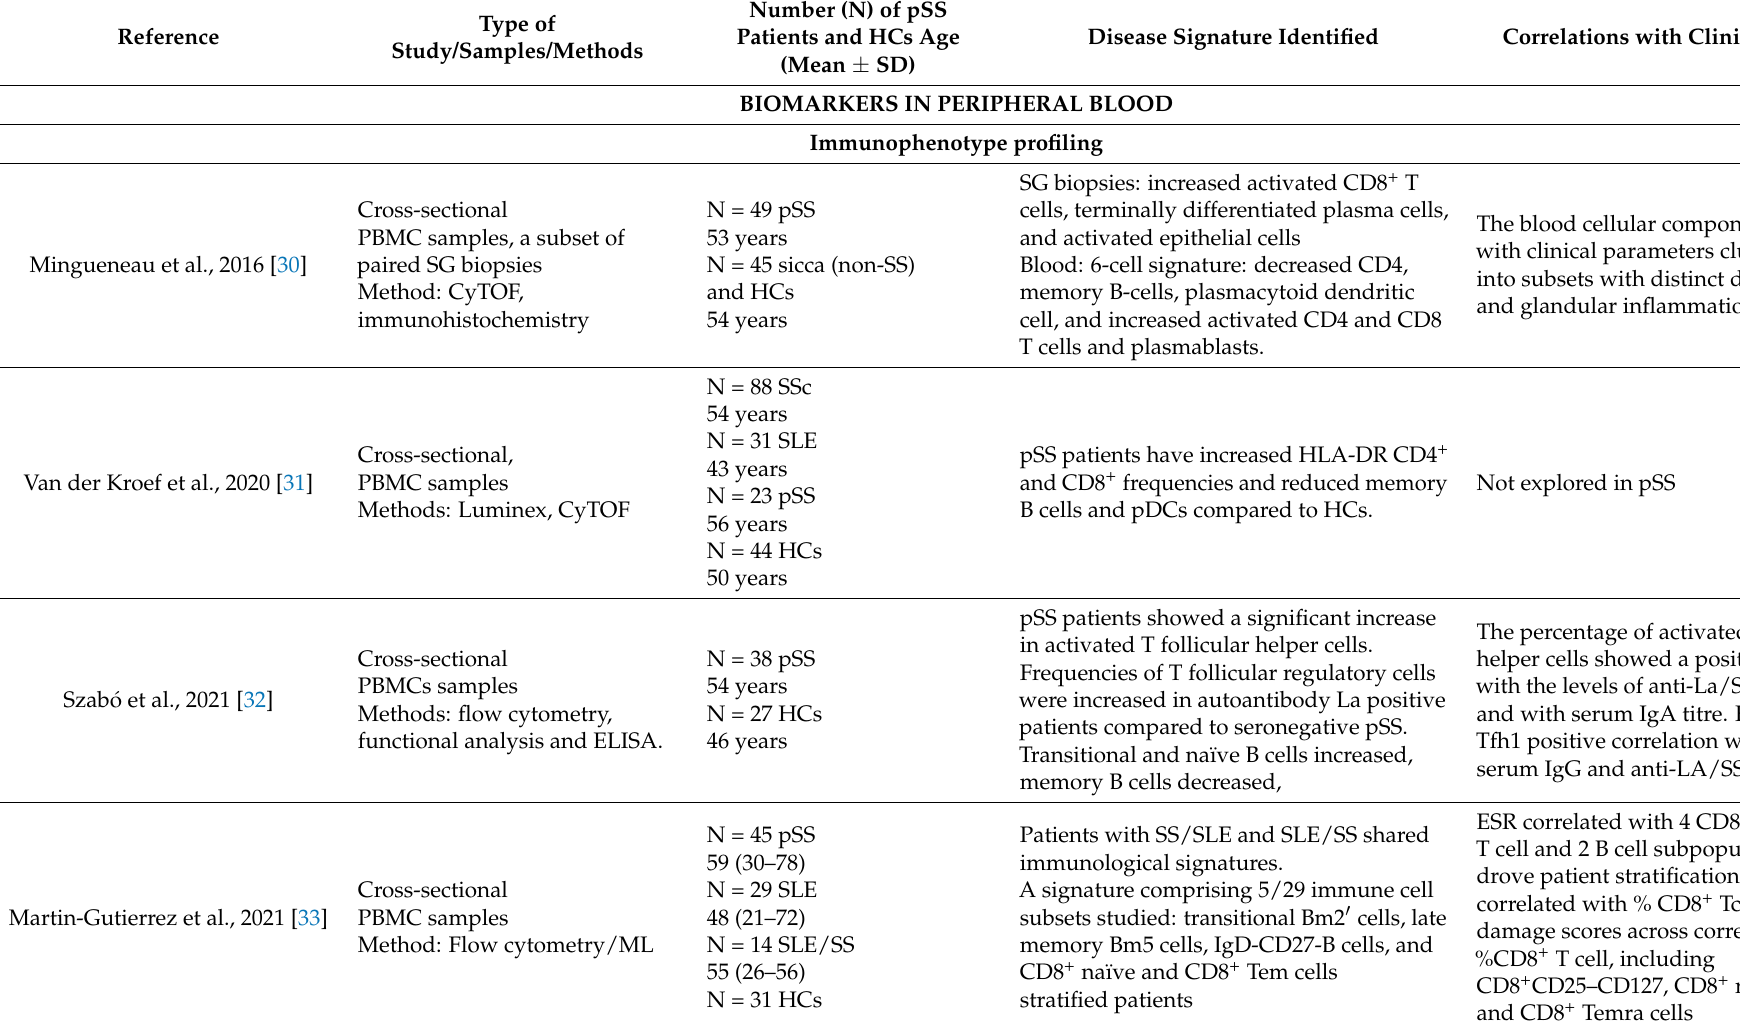
Table 3. Examples of studies investigating potential Sjögren’s Syndrome biomarkers in